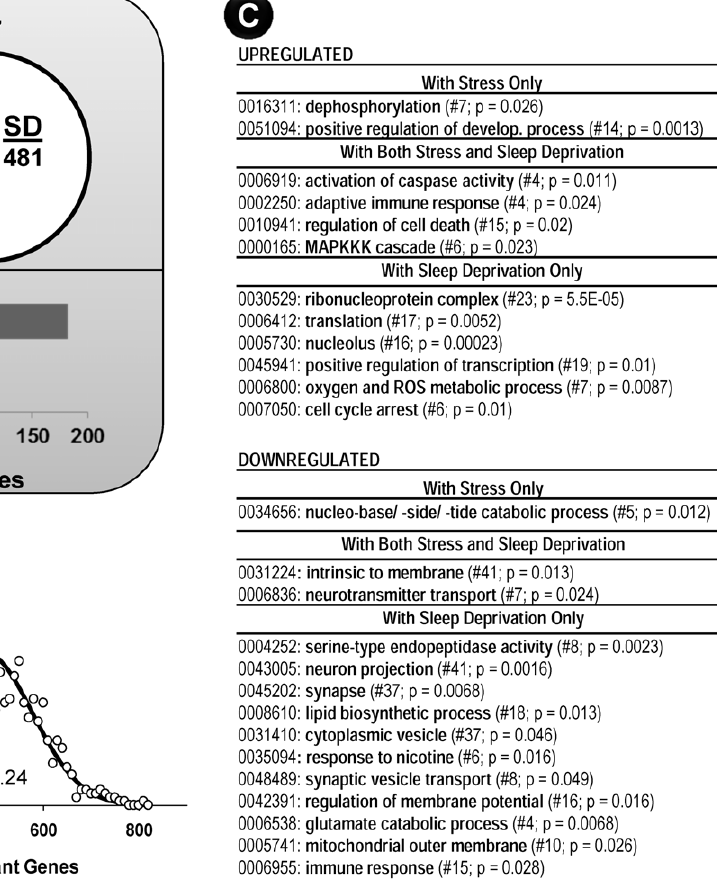
Figure 4. Novel environment stress (NES) elicited a transcriptional response highly similar to that seen with SD. A separate cohort of animals exposed to NES were subjected to hippocampal microarray analysis. Of the 2167 filtered genes, 405 were identified as significant in the stress study (p # 0.05; 1-way ANOVA; FDR =0.18). A. Venn diagram comparing stress (black circle) and SD (SD- white circle) array results reveals a highly significant overlap of 189 genes significant in both studies (* p =1.55 6 10 2 8 ; binomial test). Directional analysis revealed that 96% (182/189; 81 upregulated; 101 downregulated) of these overlapping genes agreed in direction of change. B. NES was powered by 21 microarrays, while SD was powered by 53. Because of this discrepancy, the greater number of genes found in SD could reflect increased discovery power, rather than a stronger effect of SD. To test this, we iteratively selected subsets of 21 arrays from the 53 used in the SD study and tested for significance. This was repeated 1000 times and in each iteration, the number of genes significant (p # 0.05, 1-way ANOVA) were counted. The results from all 1000 iterations are plotted as a frequency histogram (open circles). This was well-fit by a Gaussian function (heavy black line, p , 0.0001, R 2 =0.91) with a peak of 476.4- meaning that, on average if only 21 chips had been used in the SD study, we would predict that 476 genes would be found significant. Using the fit function, and the observation that 405 genes were found in the NES study, we fail to support the hypothesis that SD finds more genes than NES (p =0.24; integrated area under the curve- gray). C. Gene Ontology Analysis for genes in each region/direction of change within the Venn diagram.